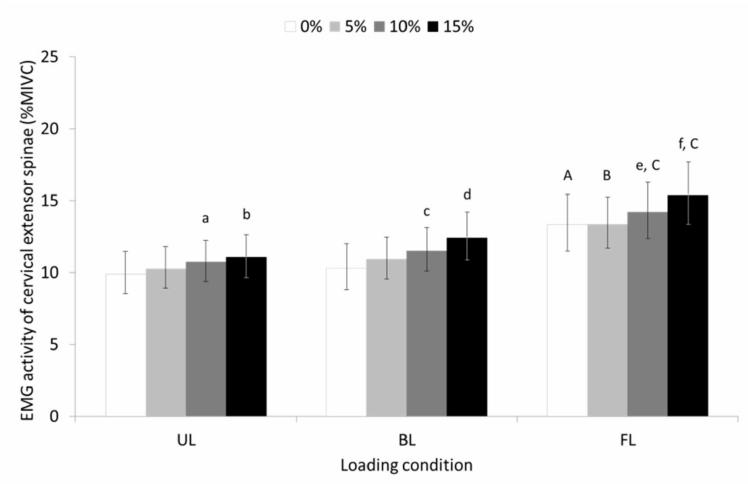
Figure 2. Geometric means and 95% confidence intervals (error bars) for the EMG activity of cervical erector spinae during unloaded (UL), back-loaded (BL), and front-loaded (FL) walking at 0 (level), 5, 10, and 15% uphill slope. a significant different (SD) compared to 0% slope ( p ≤ 0.05); b SD compared to 0 ( p ≤ 0.001) and 5% ( p ≤ 0.05); c SD compared to 0 ( p ≤ 0.05) and 5% ( p ≤ 0.01) slope; d SD compared to 0 and 5% slope ( p ≤ 0.001) as well as 10% ( p ≤ 0.01); e SD compared to 0% ( p ≤ 0.01); f SD compared to 0% ( p ≤ 0.001) as well as 5 and 10% slope ( p ≤ 0.01); A SD compared to UL and BL condition ( p ≤ 0.001); B SD compared to UL ( p ≤ 0.001) and BL condition ( p ≤ 0.05); C SD compared to UL ( p ≤ 0.001) and BL condition ( p ≤ 0.01).